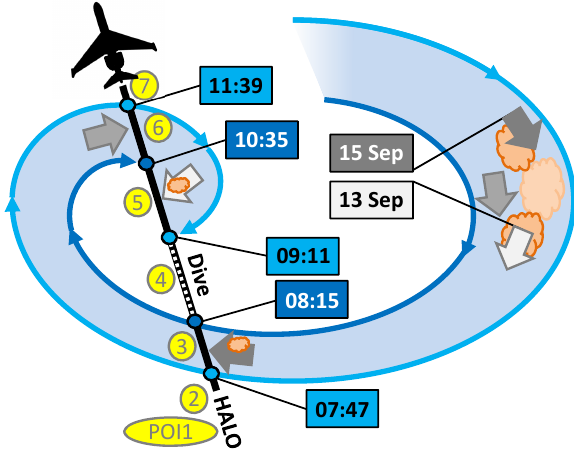
Figure 5. Schematic of the filament of UT ASMA air that was tran- sected by HALO during the ESMVal campaign. The encountered air parcels all had a similar genesis: UT air travelling in the ASMA fringe was to different degrees entrained by deep convection at the eastern ASMA flank, then continuing along the southern flank of the anticyclone to the respective measurement locations. POI3 provides the most direct view of the eastern ASMA flank. The schematic is in ASMA centred coordinates, with relative positions of air masses (grey arrows) and convection (orange clouds) indicated. The interior trajectory of the filament and corresponding times of measurement are indicated by dark blue and the exterior trajectory is light blue. Grey shades and white indicate the air masses encountered during the respective three periods of interest (POI3/5/6), and to the corre- sponding date they passed the eastern